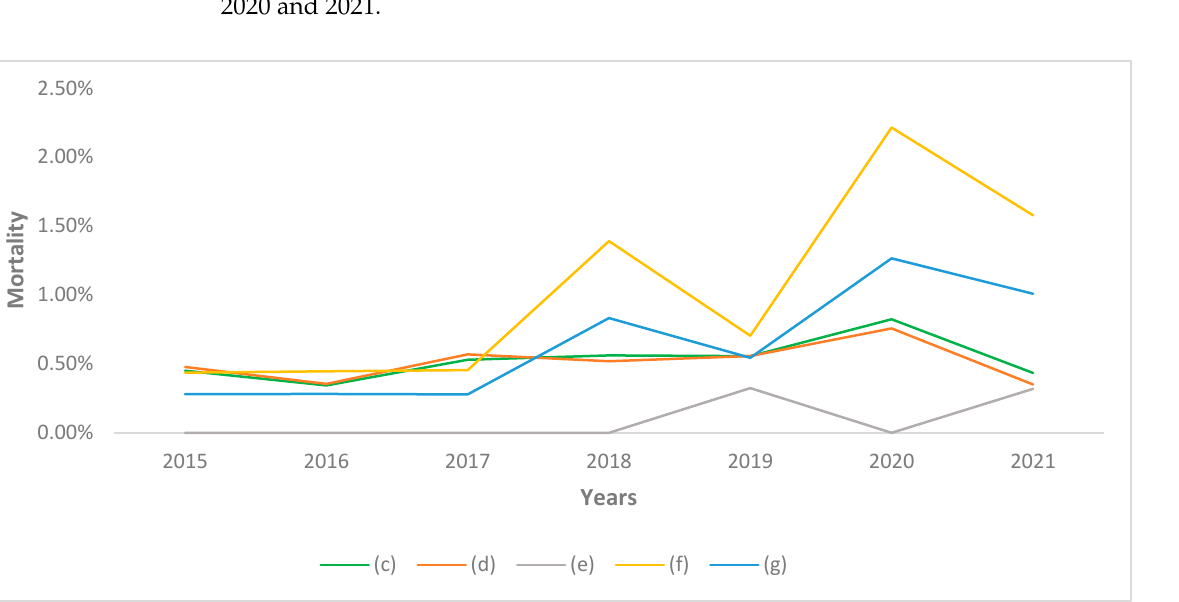
Figure 6. Variation in mortality among physicians and dentists. (c): All Doctors, (d): Physicians, (e): Dentists, (f): Physicians-Dentists, (g): All Dentists.